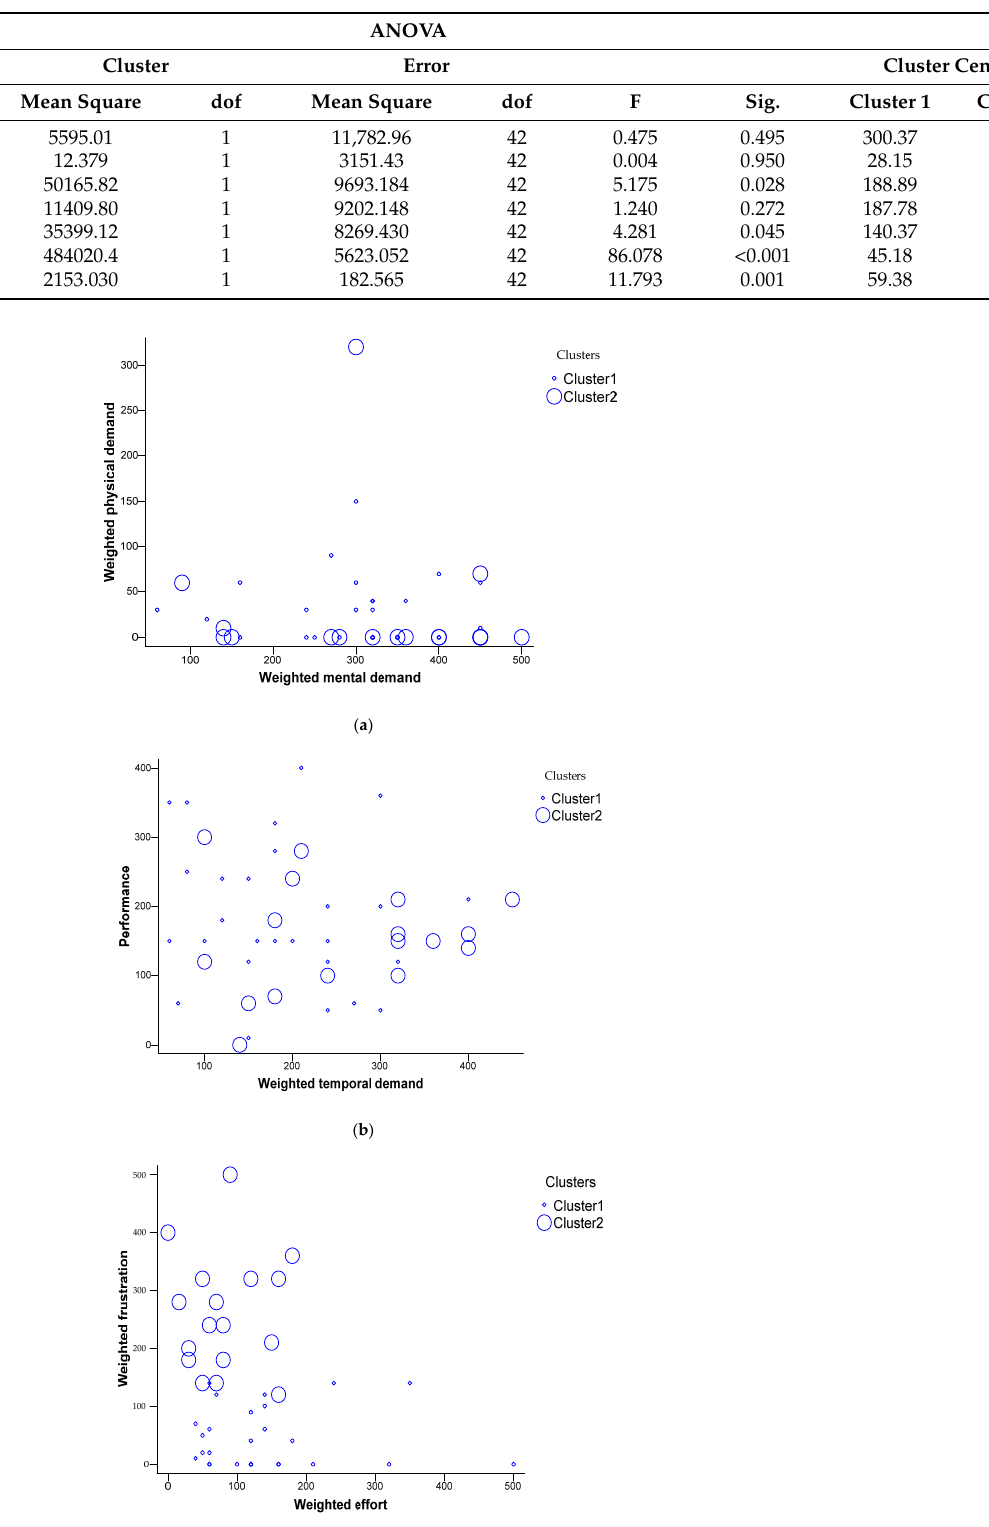
Table 9. ANOVA result of the clustering according to weighted NASA-TLX scales and overall workload, and the final cluster centers.